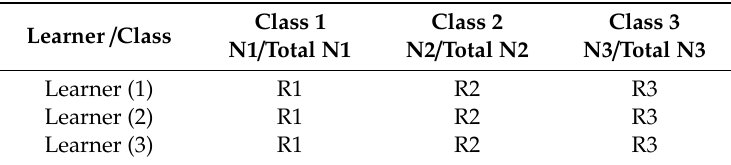
Table 5. Learners’ participation